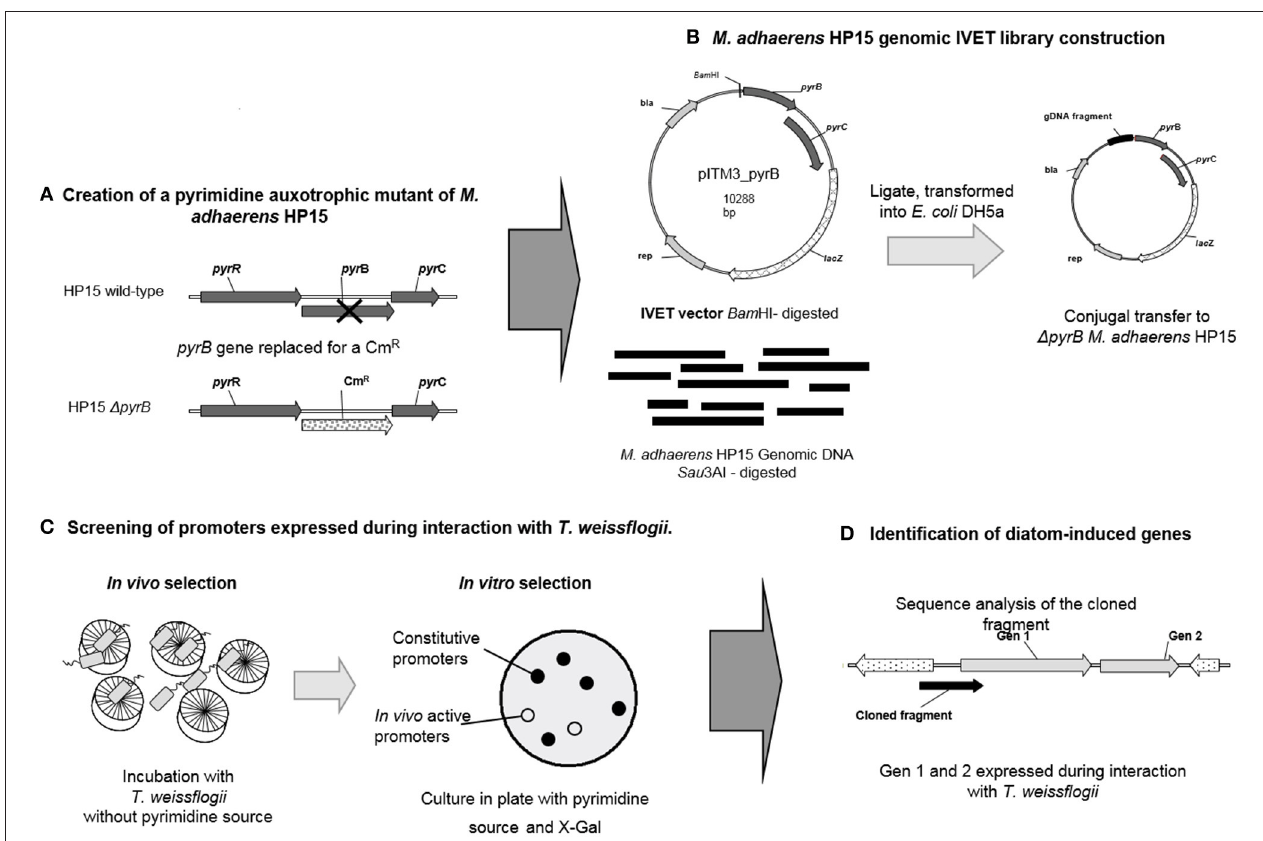
FIGURE 1 | Schematic representation of IVET strategy. (A) An auxotroph mutant in M. adhaerens HP15 was created by replacing the gene pyrB with a chloramphenicol resistant cassette (Cm R ). This mutant is unable to grow in the absence of a pyrimidine source; (B) A genomic library was generated in the pITM3-pyrB plasmid by digesting the genomic DNA of HP15 and cloning the resulting fragments into the Bam HI site of the plasmid. The resulting plasmids were transformed into HP15 by triparental conjugation; (C) For the selection of promoters active during the interaction the trasnconjugants of HP15 1 pyrB carrying the genomic library in pITM3-pyrB were incubated with T. weissflogii , without the addition of a pyrimidine source. Then the survival trasnconjugants were plated in agar media supplemented with pyrimidine and X-Gal, the brownish (non-blue) colonies, which contain active in co-culture promoter, were selected; (D) The plasmid DNA was extracted from the positive colonies, the fragment upstream the fusion pyrB-lacZ was PCR amplified and sequenced. The genes under the control of the promoter found in the DNA fragment were identified.